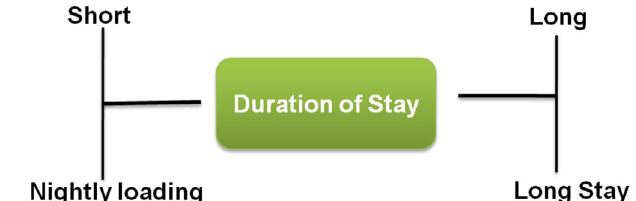
Figure 4. Analogy of a timeline of the duration of stay.